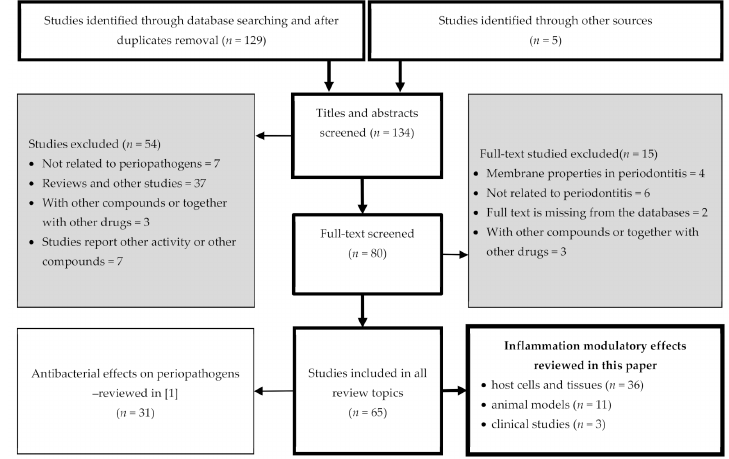
Figure 2. Flowchart of the article search strategy, exclusion criteria, study selection, and data management process. Of all 65 considered references, 50 are reviewed in this paper and 31 in [1], of which 16 references are included in both